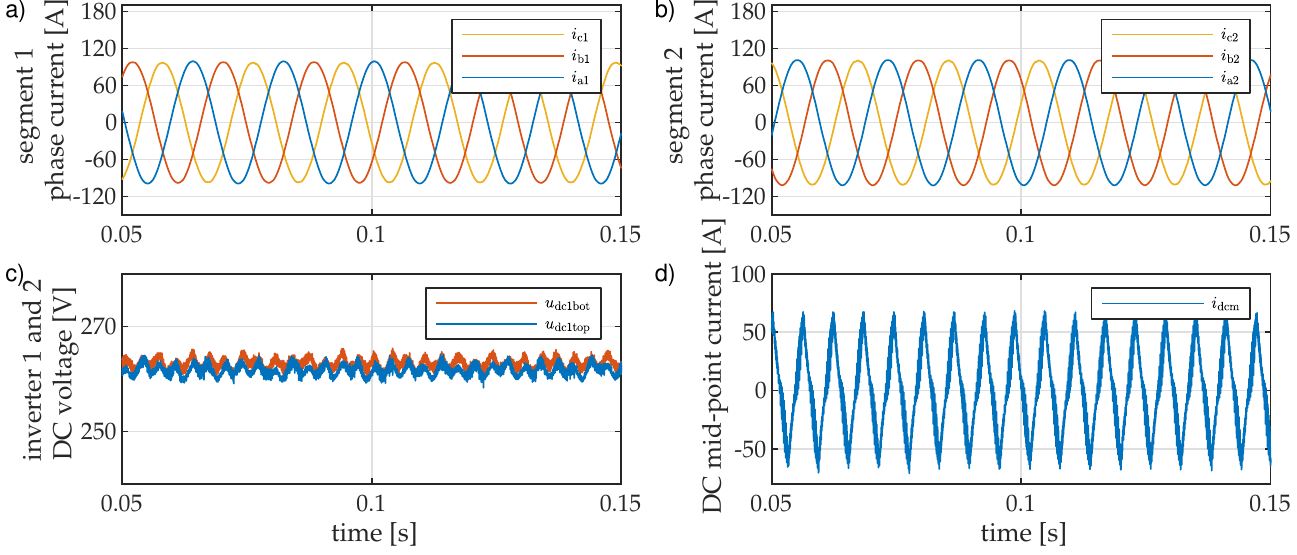
Figure 21. DC circuit analysis in dual-inverter configuration—experimental results, ( a ) inverter 1 output current, ( b ) inverter 2 output current, ( c ) common DC circuit voltages, ( d ) current between mid-points of DC